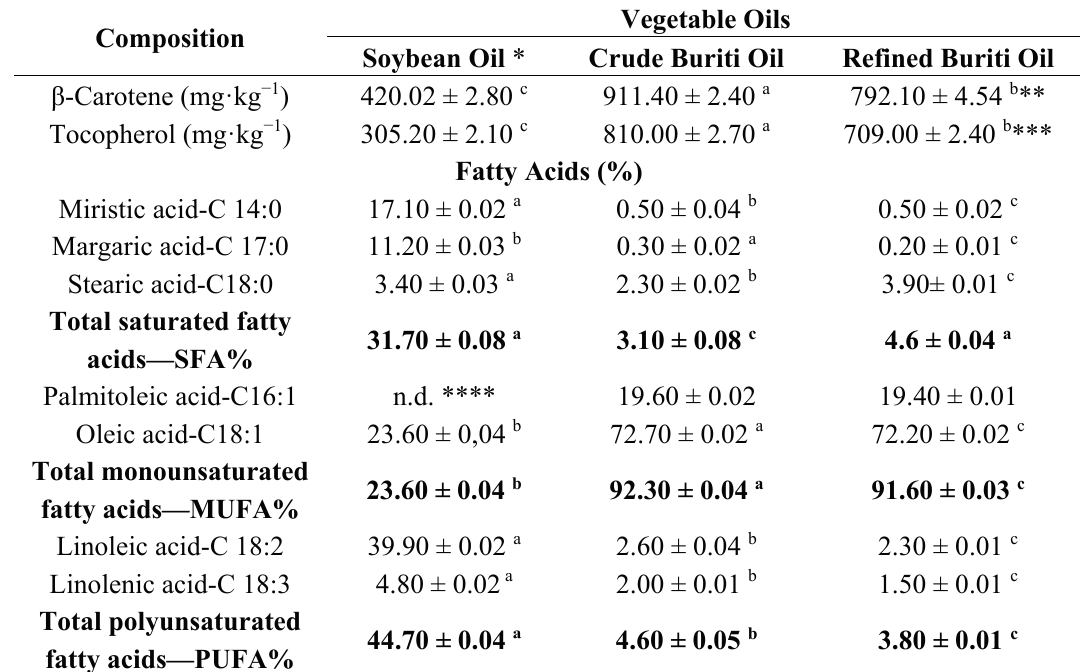
Table 4. Fatty acids, β -carotene and tocopherol present in soybean oil, crude and refined buriti oils.